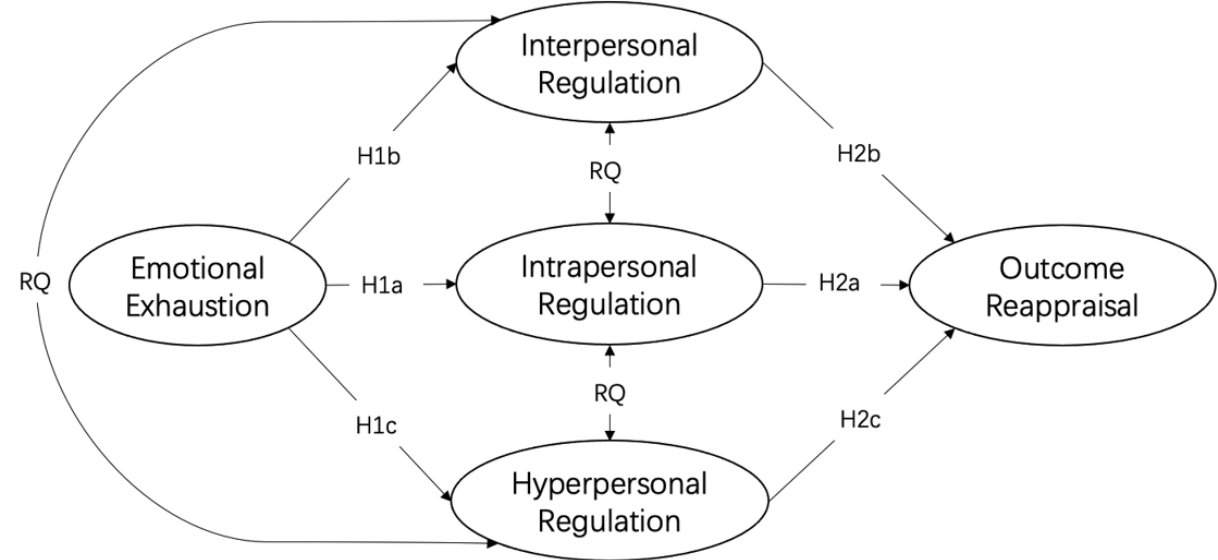
Figure 1. Conceptual model. H: hypothesis; RQ: research